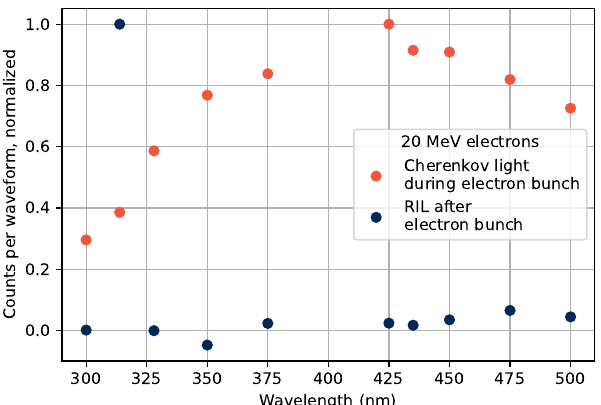
Figure 3. RIE spectra from 20 MeV electrons at a normal incidence angle without any water equivalent material above the sample. The luminescence detected after the electron bunches is shown in blue, and the prompt radiation response during the electron bunch in